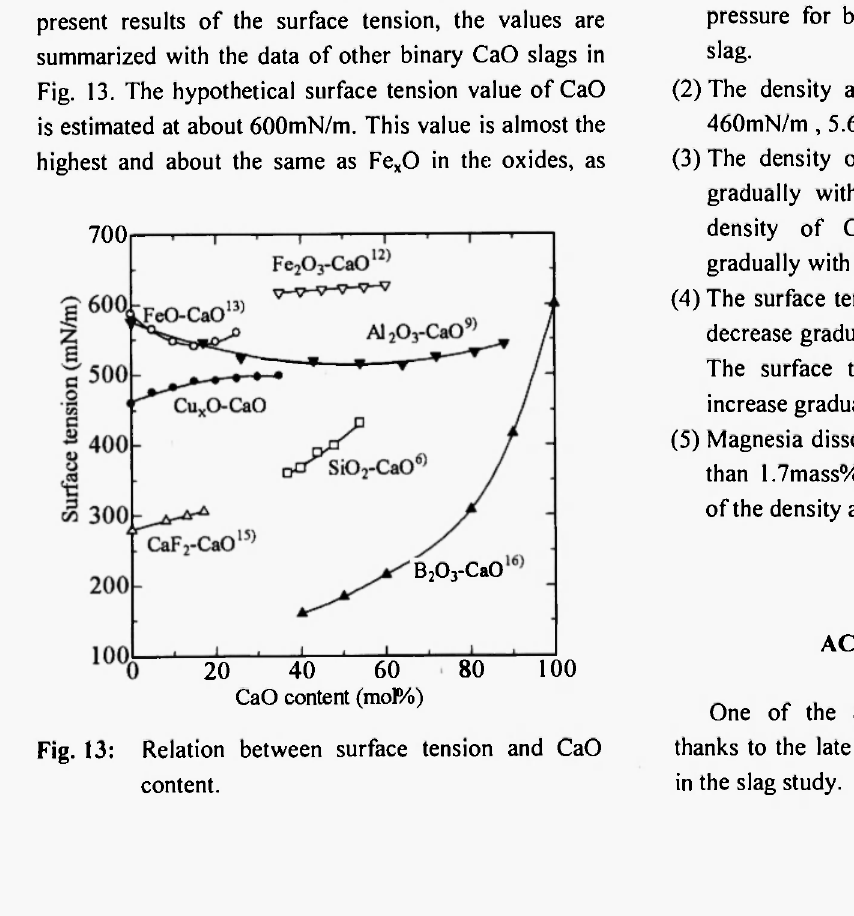
surface tension of 460mN/m of Cu x O melt, the surface tension tends to increase with an increase in CaO content and change of the surface tension is not linear but a small positive deviation with CaO content. No theoretical explanation for the data is now available.